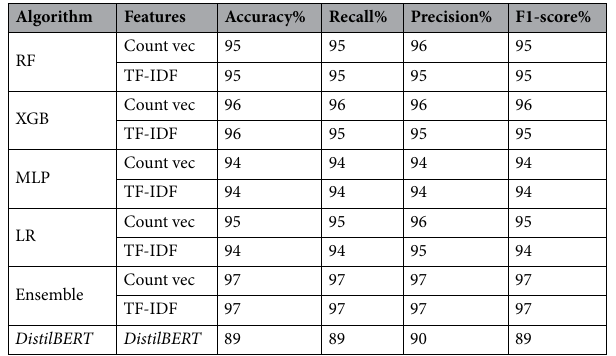
Table 2. All Feature Extraction and algorithm Results for Article1 Dataset with 10 Authors.